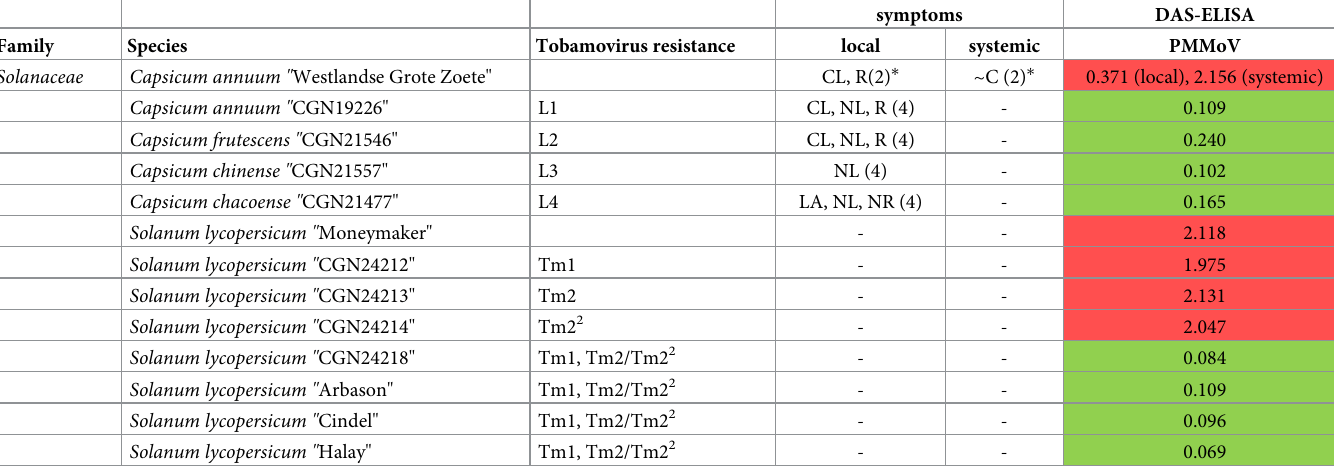
Table 4. Pathotype analysis: Symptomatology and DAS-ELISA results of tomato ( S . lycopersicum ) and pepper ( Capsicum spp.) accessions harboring different (com- binations of) tobamovirus resistance genes after inoculation with the novel